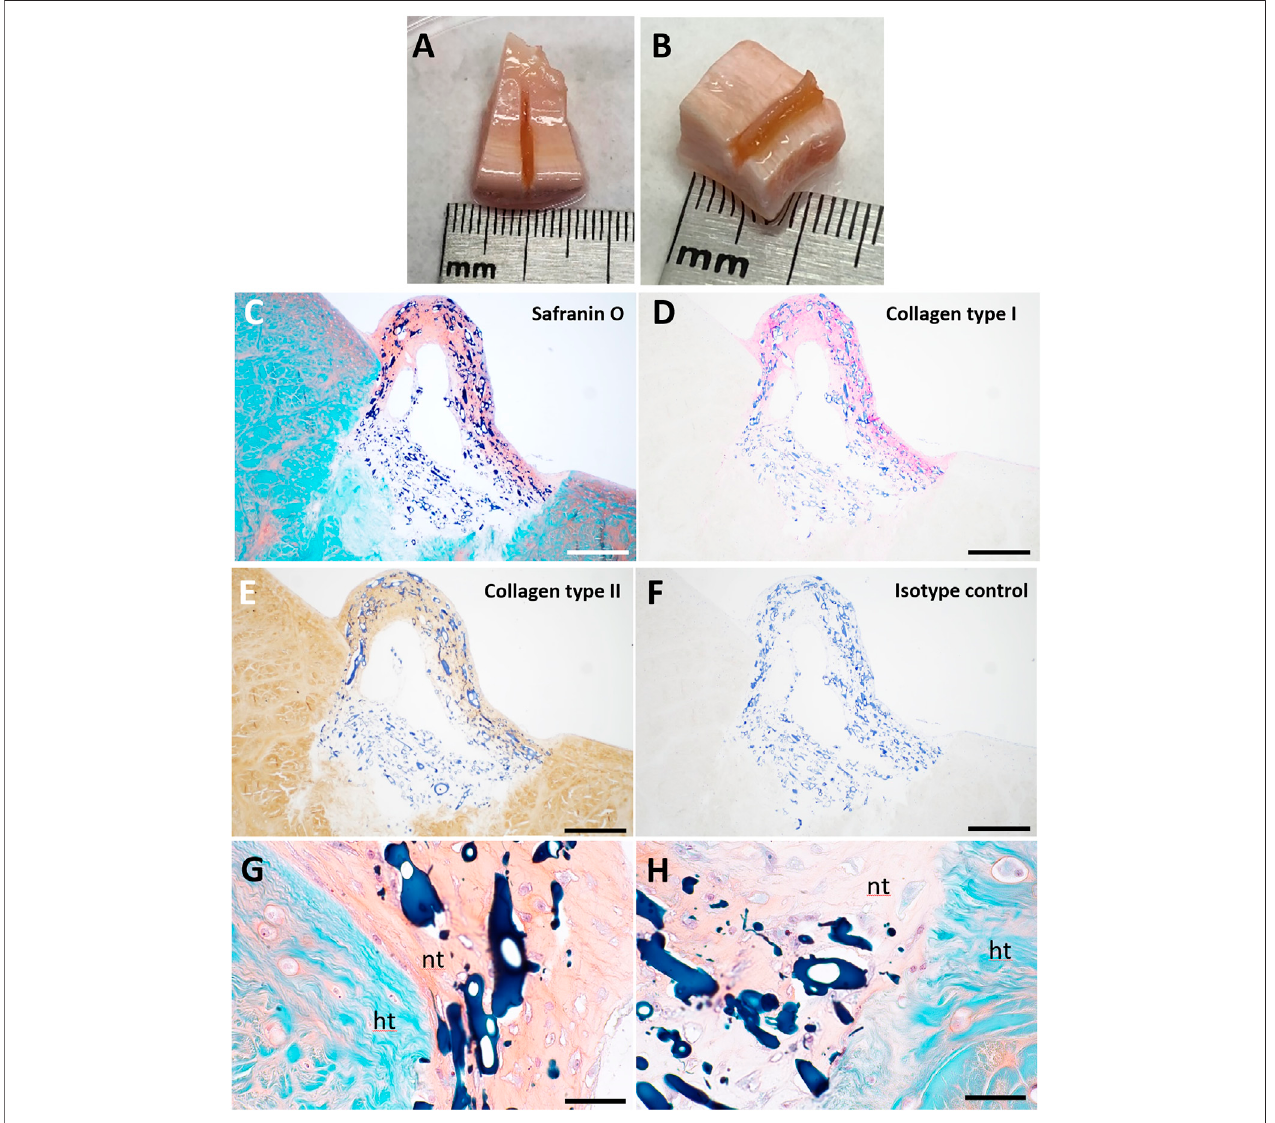
FIGURE 5 | Pneumatospun collagen scaffolds seeded with human IPFP cells and implanted into ex vivo bovine meniscus and culture for 3 weeks. (A,B) Photographsofimplanted collagenscaffolds. (C) SafraninOstaining. (D) CollagentypeIimmunostaining. (E) Collagen typeIIimmunostaining. (F) Isotype control. (G,H) Highermagni fi cationofSafraninOstainedimageshowingintegrationofneotissue(nt)withhosttissue(ht).Thecollagenscaffoldisstaineddarkblue.(C-FBar=200 μ m; G-H Bar = 50 μ